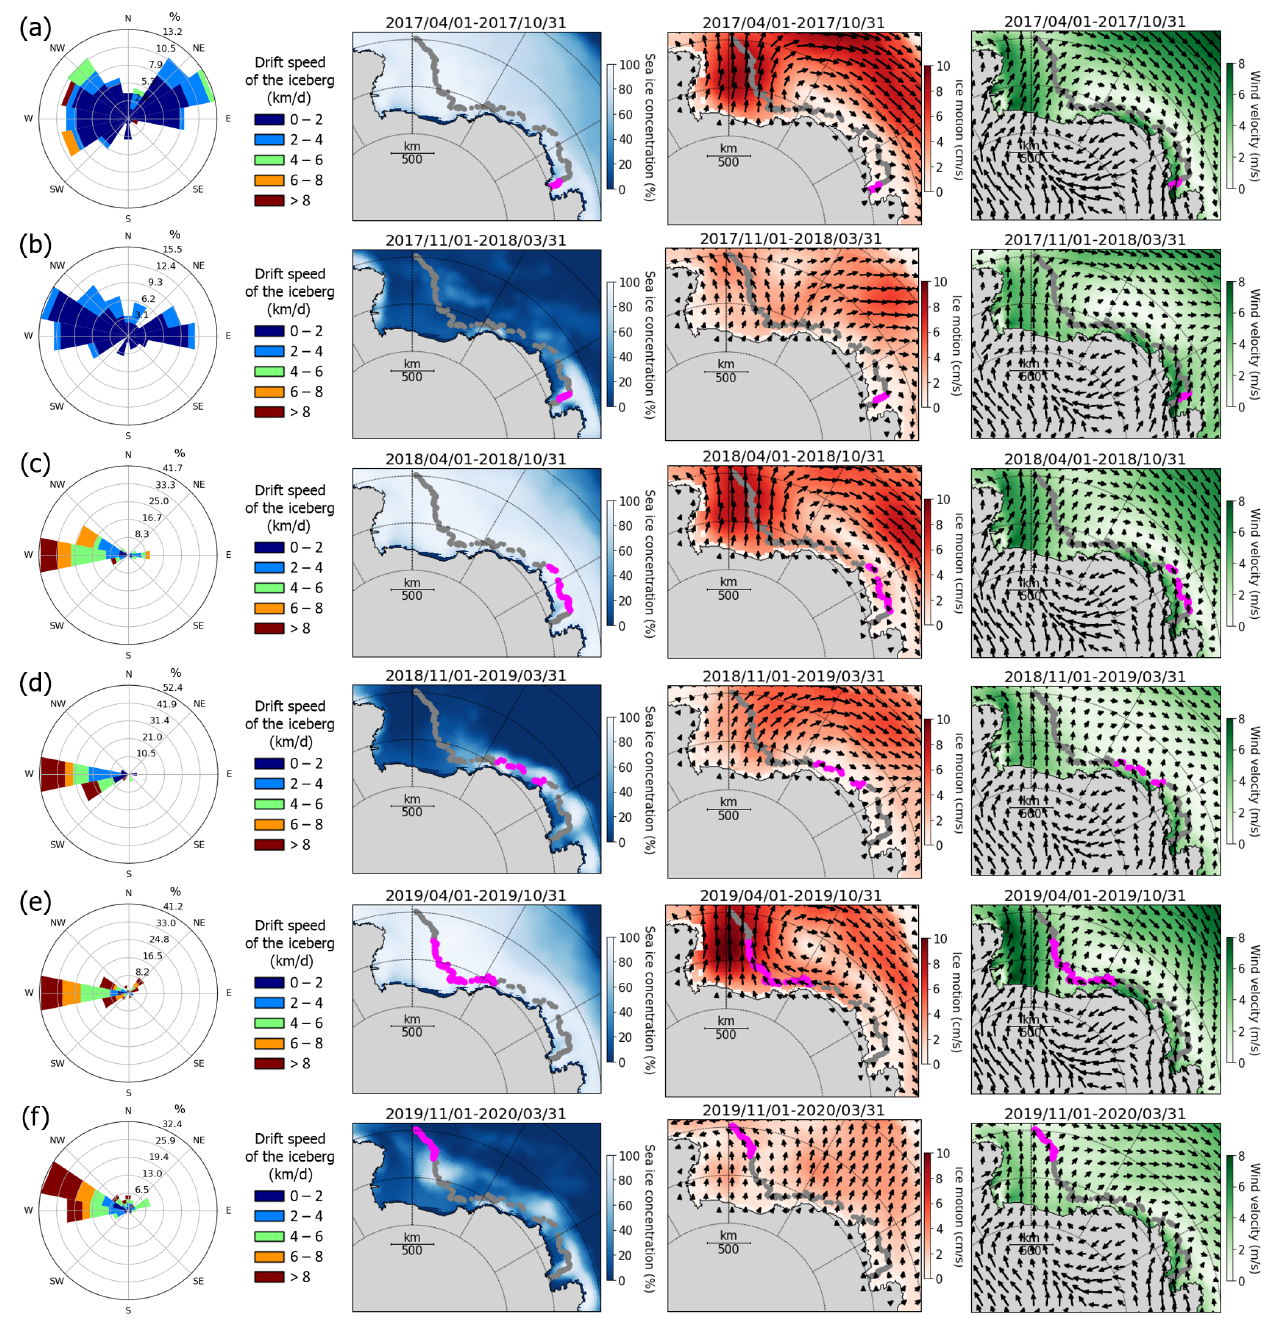
Figure 6. Multipanel plots with left-to-right columns respectively indicating rose diagrams of iceberg velocity, average sea ice concentra- tion (SIC), average ice motion velocity, and average wind vector velocity. The rows correspond to the six averaging periods selected in Fig. 5: (a) April–October 2017, (b) November 2017–March 2018, (c) April–October 2018, (d) November 2018–March 2019, (e) April– October 2019, and (f) November 2019–March 2020. The entire track of the iceberg is indicated in all the maps (gray solid circles) as well as the track segments for each of the six periods (magenta solid